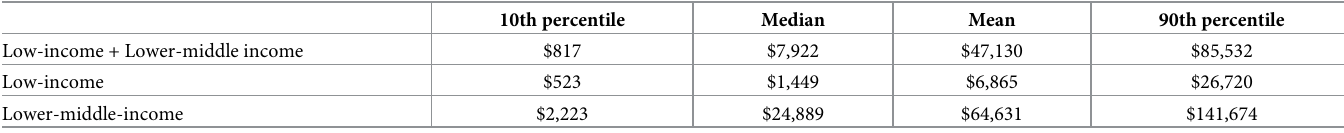
Table 5. Cost ($) per poverty case averted, using social protection program